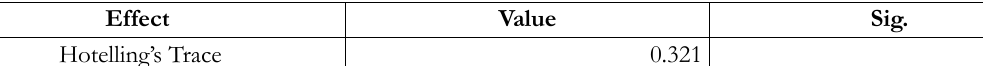
Table 10. Result of MANOVA